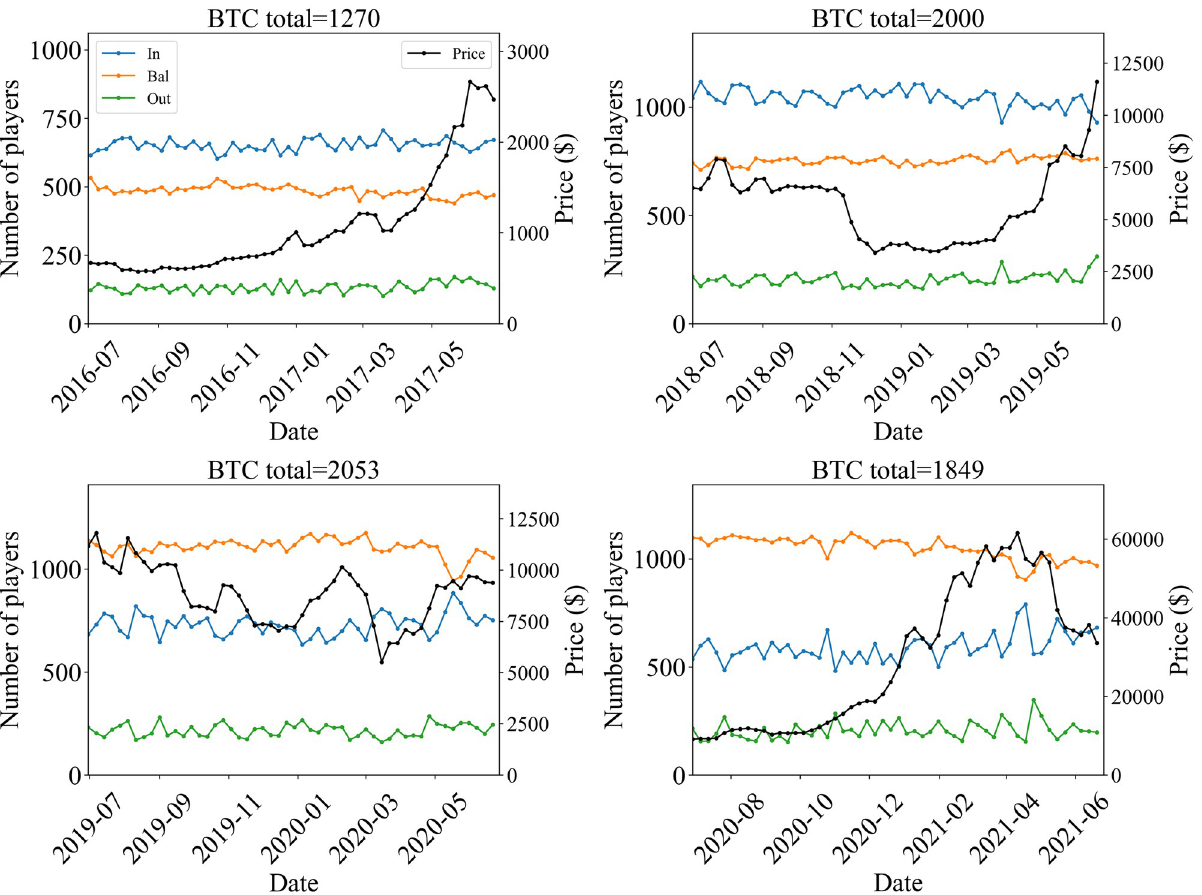
Fig 10. Time series of the number of regular In-, Bal-, and Out-players (weekly total) of Bitcoin for periods (July 3 2016 Sunday to July 1 2017 Saturday), (July 1 2018 Sunday to June 29 2019 Saturday), (Jun 30 2019 Sunday to June 27 2020 Saturday), and (June 28 2020 Sunday to June 26 2021 Saturday). The black line represents the one-week-average